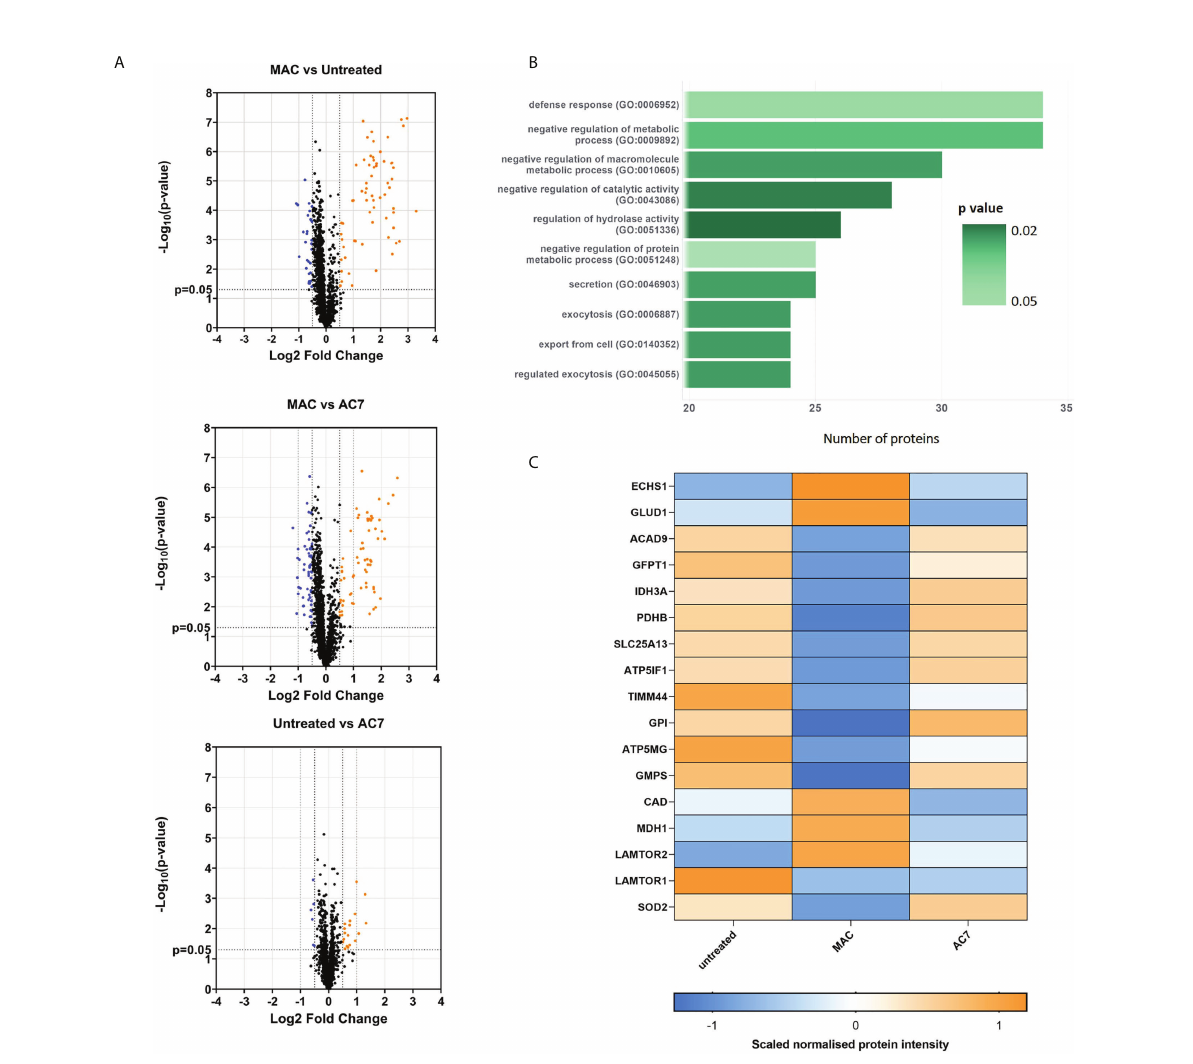
(A) Volcano plots representing all proteins from the analysis using a fold change cut-off of 0. 5 and unpaired t-test p < 0.05. (B) Top 10 list of MAC upregulated pathways from proteomics data using statistical enrichment test for GO biological processes analysis (N= 99 upregulated proteins). See methods section . (C) Hierarchical clustering of normalized protein intensities (z-score) for signi fi cantly regulated metabolic proteins of interest, which were identi fi ed as described in the main text and methods section. Statistical analysis performed in (C) was